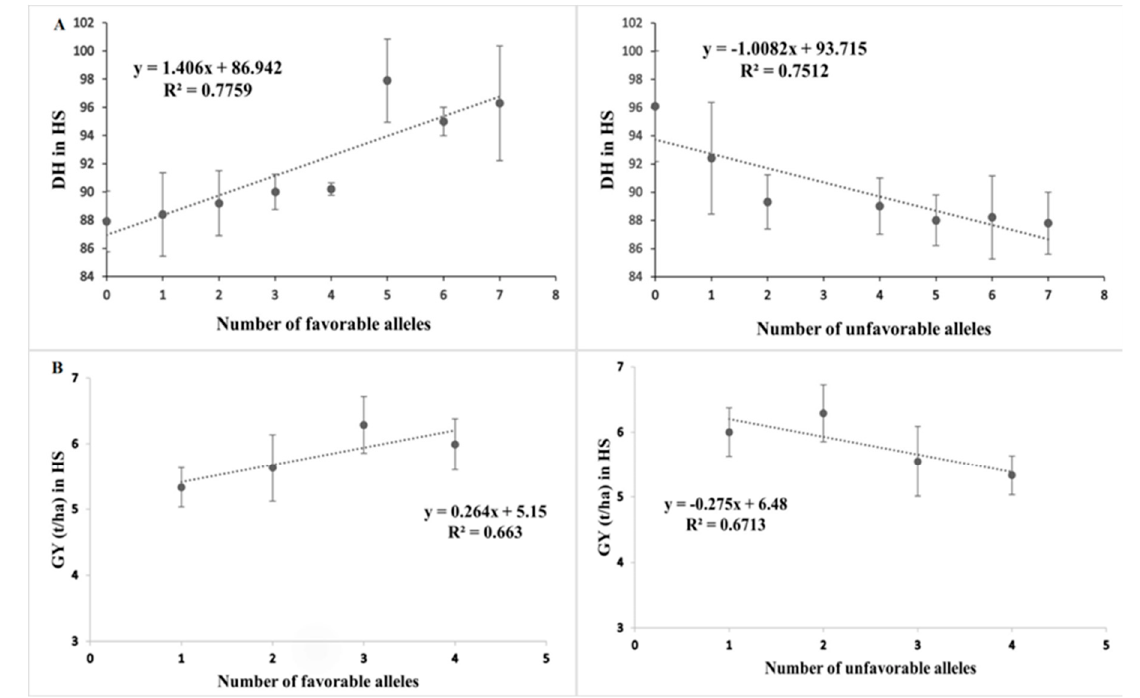
Figure 3. Scatterplot showing the effects of favorable and unfavorable alleles on the yield traits DH (days to heading) and GY (grain yield). In ( A ) the effect of number of favorable alleles and unfavorable alleles on DH in HS condition is shown and in ( B ) the effect of number of favorable and unfavorable alleles on the grain yield is shown.